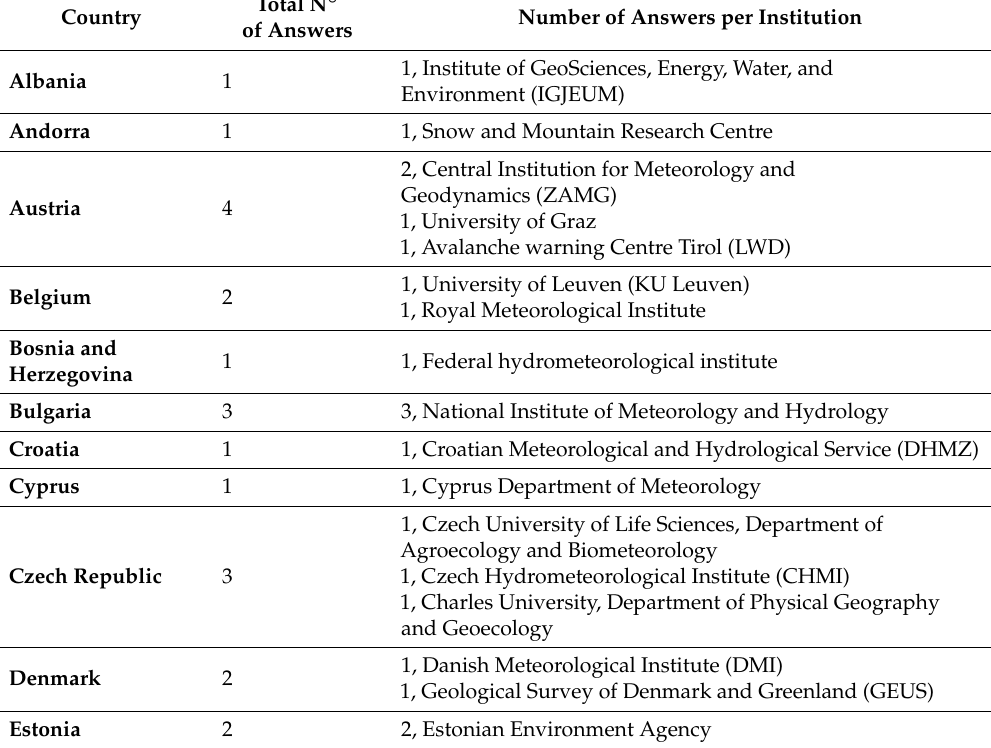
Table A7. List of European countries participating in the survey, with the total number of answers per country (second column), and the number of answers per institution (third column). The names of the institutions are provided in English. For clarity, the names of the institutions in the original languages (or their acronym) are provided in parenthesis for those cases in which the English translation is not commonly applied or the original acronym is widely